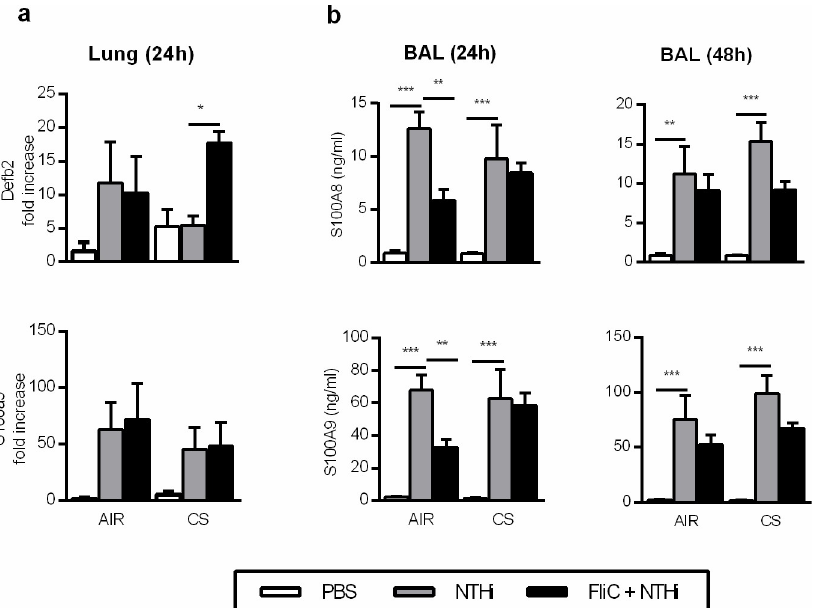
Fig 5. Effect of flagellin on the production of anti-microbial peptides in CS-exposed mice infected with NTHi. (a) mRNA expression of Defb2 , S100A8 and S100A9 in the lungs of control versus CS-exposed mice infected or not with NTHi and treated or not with flagellin. (b) Concentrations of Defb2, S100A8 and S100A9 in the BAL of control versus CS-exposed mice infected or not and treated or not with flagellin. BAL were collected 24h and 48h after infection. Three independent experiments have been performed with at least 3 mice in each group. The data are expressed as mean ± SEM � : p < 0.05, �� : p < 0.01, ��� : p < 0.001.